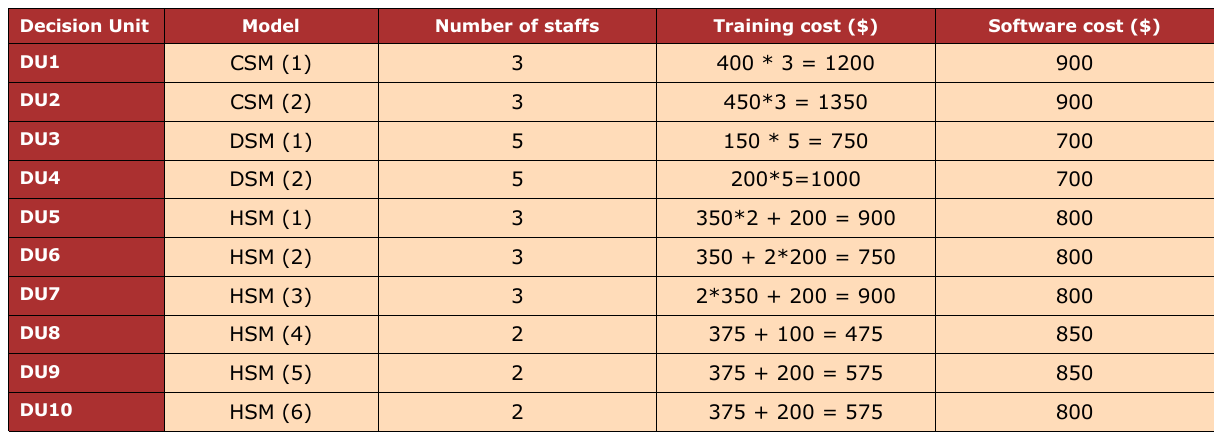
Table 7. DEA inputs for the setting with high interaction